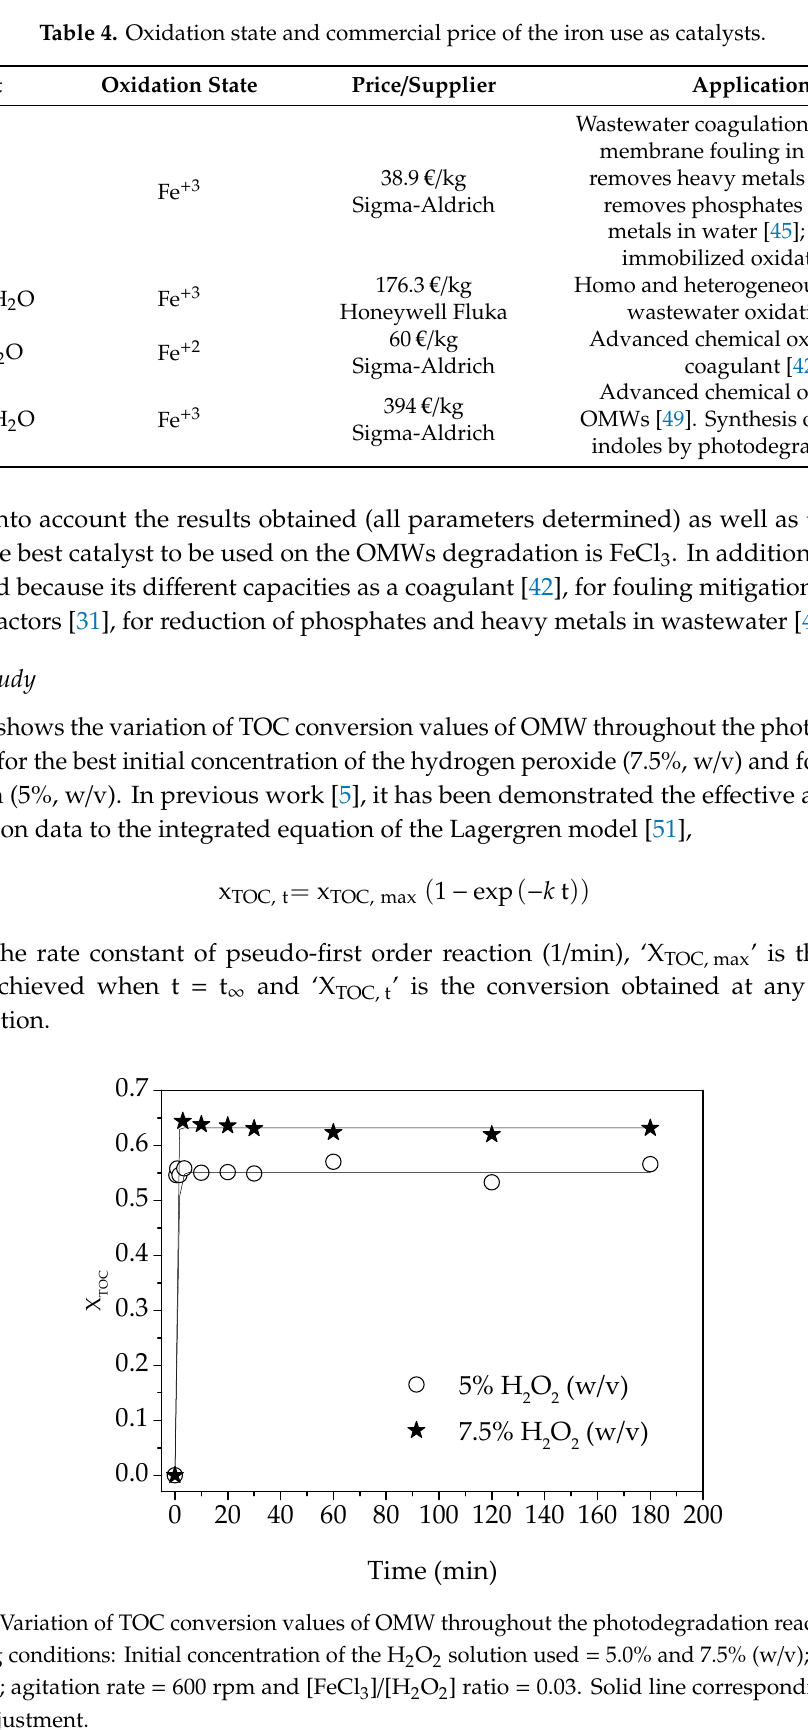
Table 5. Kinetic parameters determined for the best operational conditions of each catalyst used. Operational conditions: pH = 3, T = 20 °C, agitation rate = 150 rpm and [Catalyst]/[H 2 O 2 ] ratio = 0.03. Catalyst